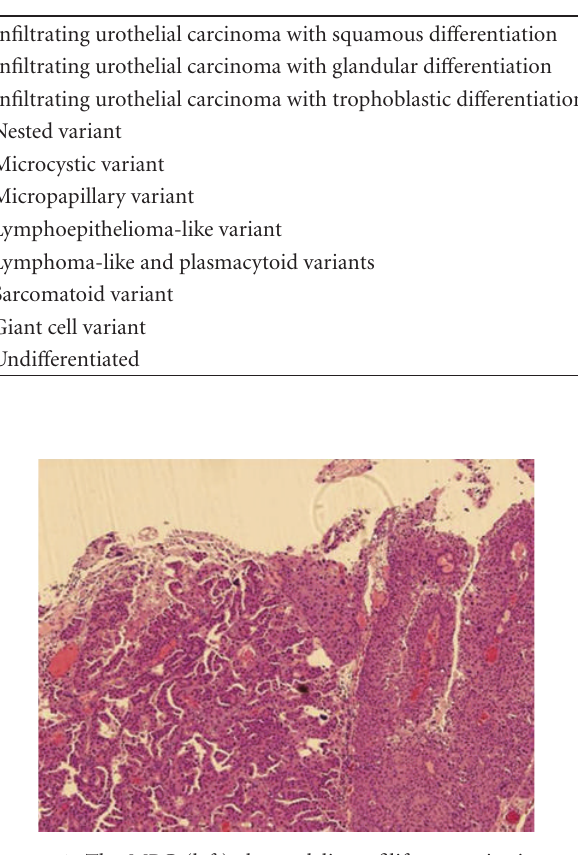
Figure 1: The MPC (left) shows delicate filiform projections on the mucosal surface, di ff erent from the ordinary type of papillary carcinoma (right).